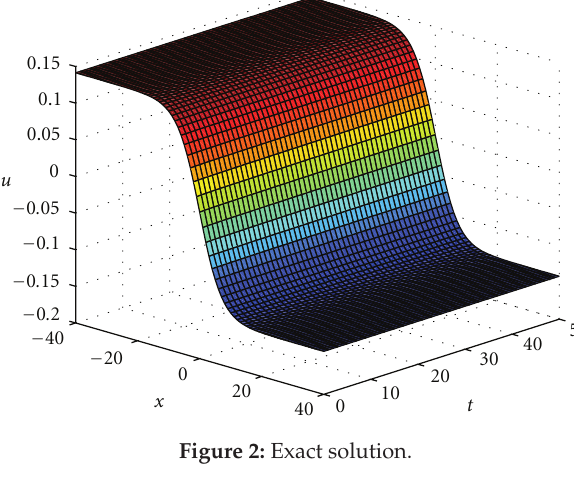
Figure 2: Exact solution.